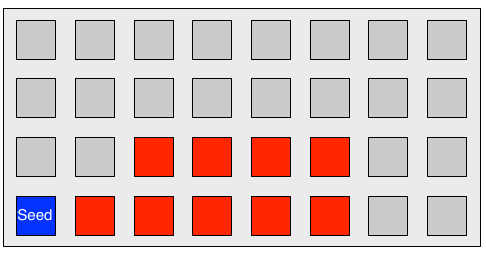
Figure 7. An example of a footprint